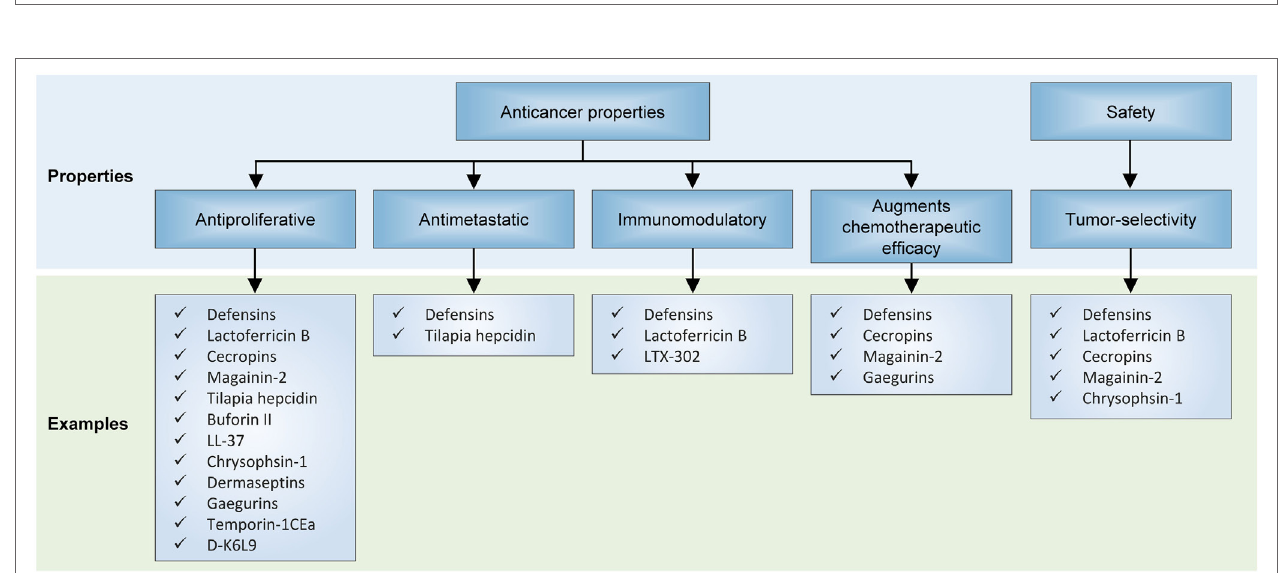
FiGURe 3 | Crystal structures of selected antimicrobial peptides (AMPs) with anticancer potential. Protein databank accession codes: human beta-Defensin-3, IKJ6; cecropin B derivative CB1a, 2IGR; lactoferricin B, 1Y58; magainin 2, 2MAG; LL-37, 2K6O; Dermaseptin analog NC12-K4S4(1–13)a, 2DCX; Gaegurin 4, 2G9L; Temporin-1 Ta,